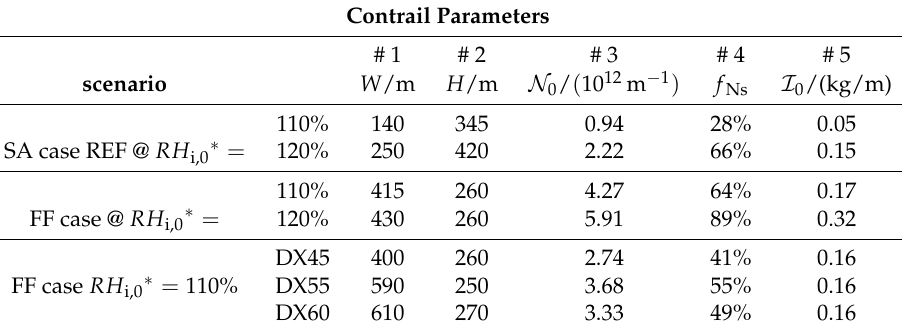
Table 3. Initial contrail properties: f Ns is the fraction of ice crystals that survive the vortex phase and is determined by f Ns = N 0 / N 00 . In the single aircraft case N 00 = 3.4 × 10 12 m − 1 and in the formation flight scenario N 00 = 6.8 × 10 12 m − 1